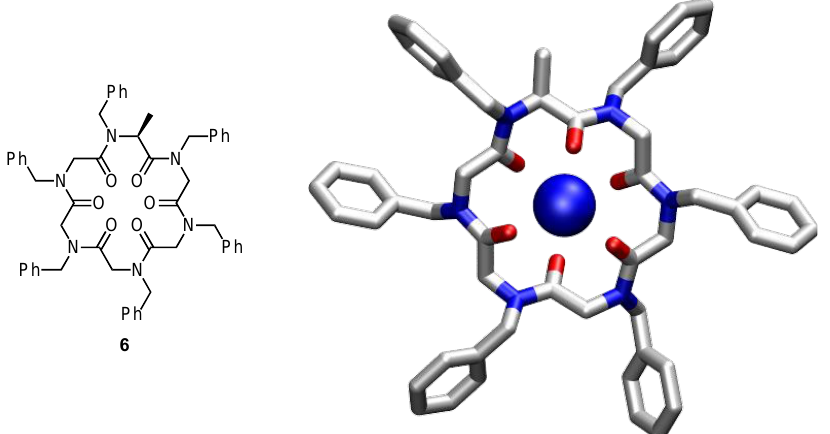
Figure 4. Structure of the cyclic peptoid 6 and calculated structure of its Na + complex. The calcula- tions were performed by the author of this review based on the reported results by using Spartan 20 (Wavefunction, Inc., Irvine, CA, USA) and the MMFF force-field (see Supporting Information). Protons are omitted for reasons of clarity.